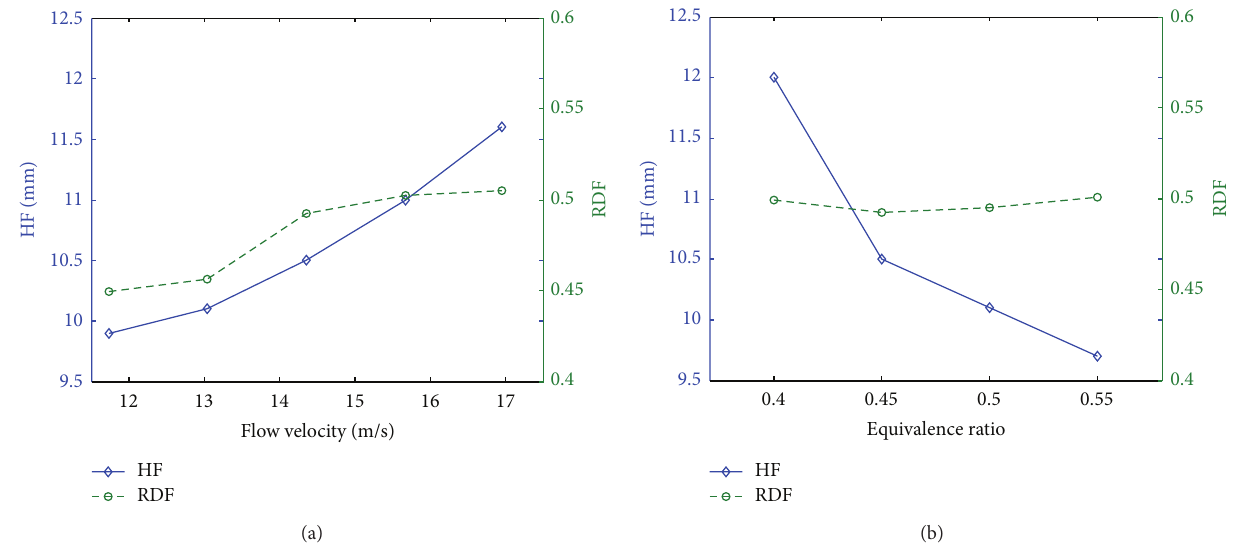
Figure 11: HFs and RDFs in different flame conditions: (a) flow velocities; (b) equivalence ratios.